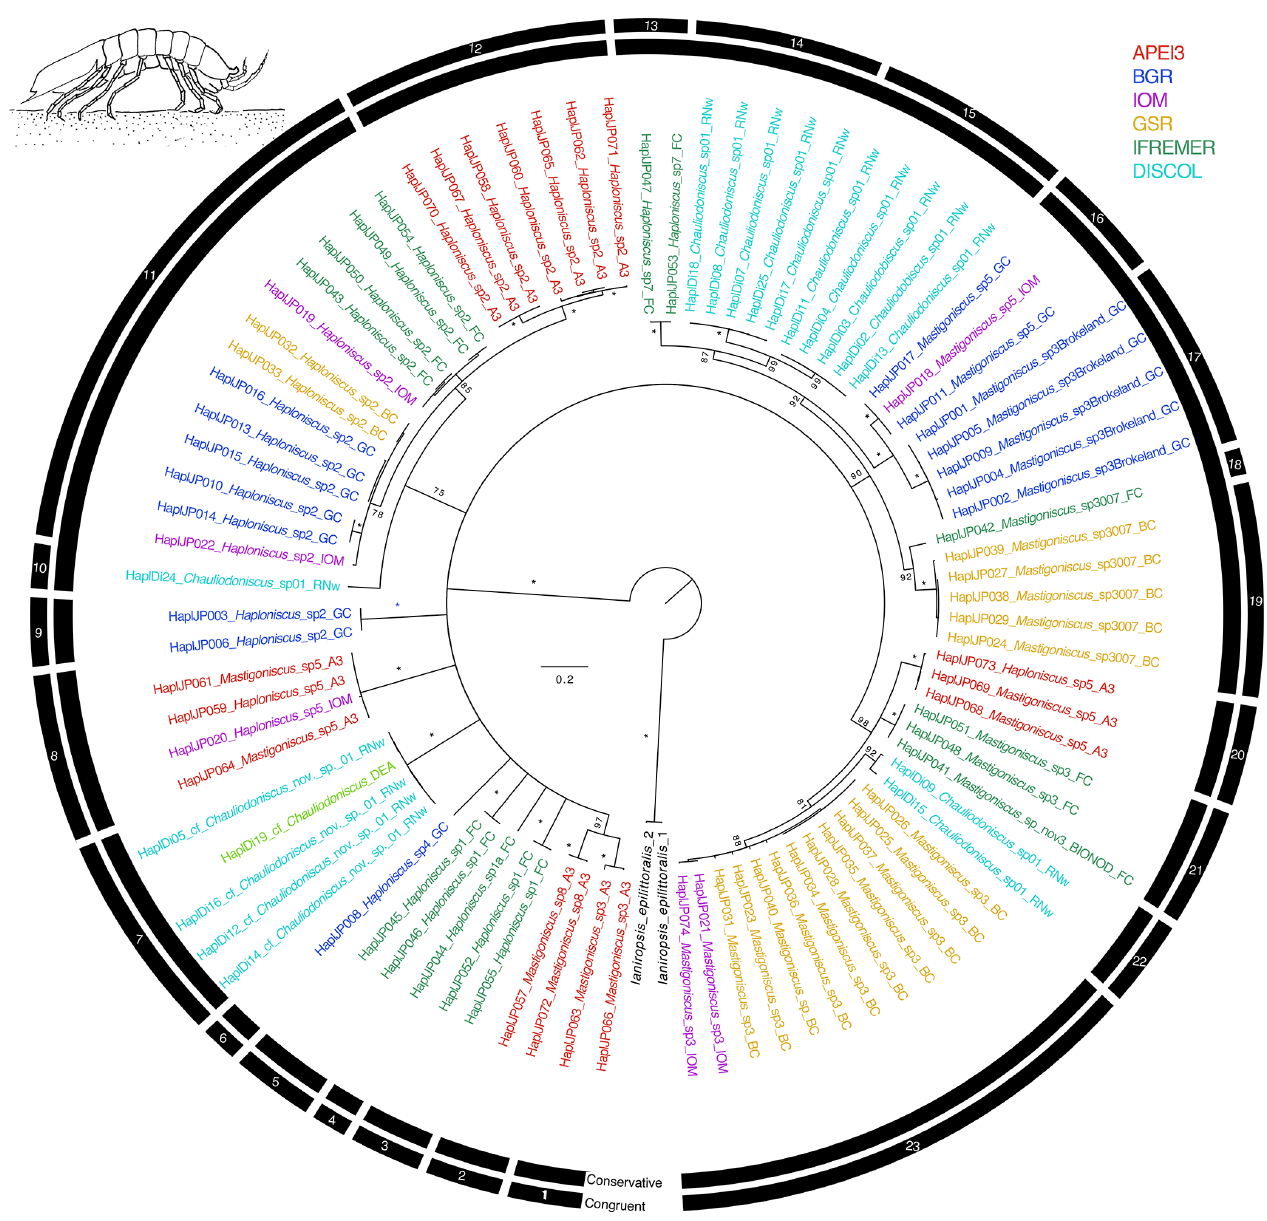
Figure 5. Phylogenetic tree of all haploniscid samples based on 16S and COI sequences for 88 specimens. Colors indicate collection location with black indicating outgroups. All unsupported branches were collapsed, and bootstrap support is indicated with asterisks indicating 100% bootstrap support. The outer two bars summarize the results of the species delimitation analyses which included morphological determination, VSEARCH for individual genes, ABGD for individual genes, and PTP and mPTP for both individual genes and the concatenated datasets. The conservative bar indicates that all SD analyses supported that split, while the congruent bar indicates that the majority of SD analyses showed that split. Numbers on congruent bars are arbitrary and are provided to allow a way to refer to specific supported